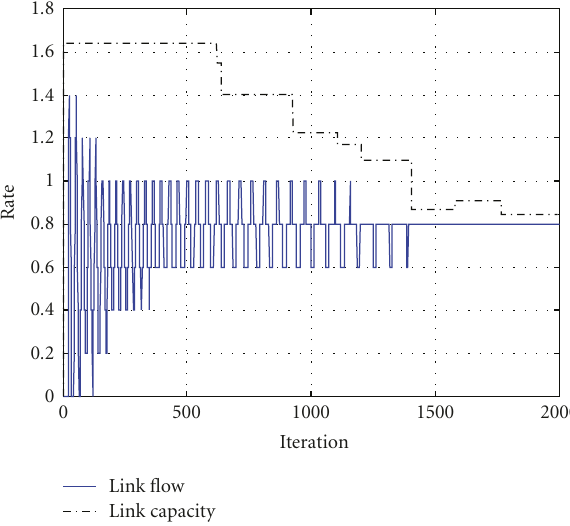
Figure 4: The flow and capacity of links 4 and 5.